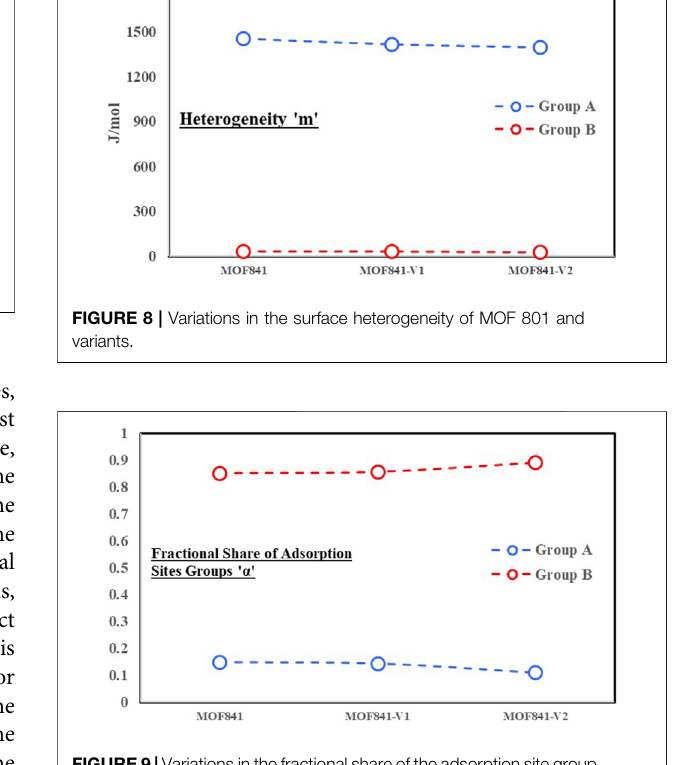
FIGURE9| Variations inthe fractional share oftheadsorption sitegroup in MOF 801 and